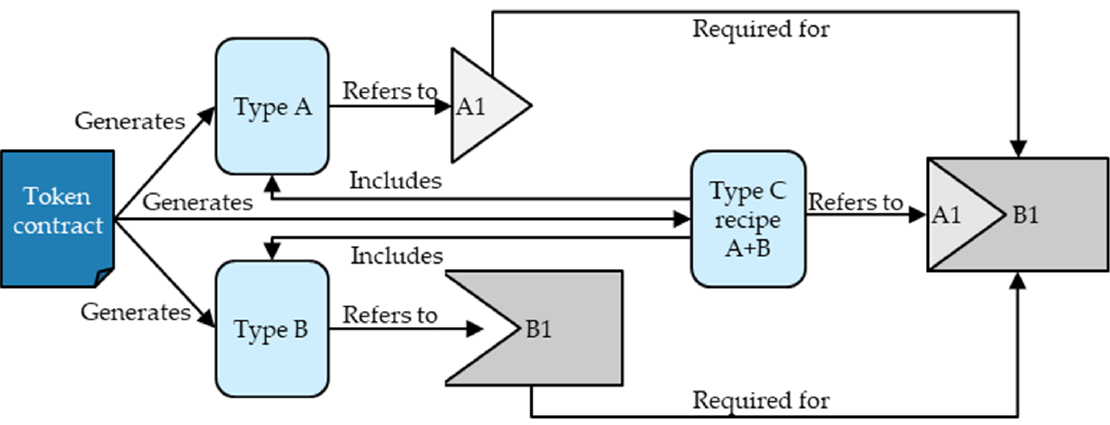
Figure 3. Required interplay of NFTs and minting conditions for assembly processes.